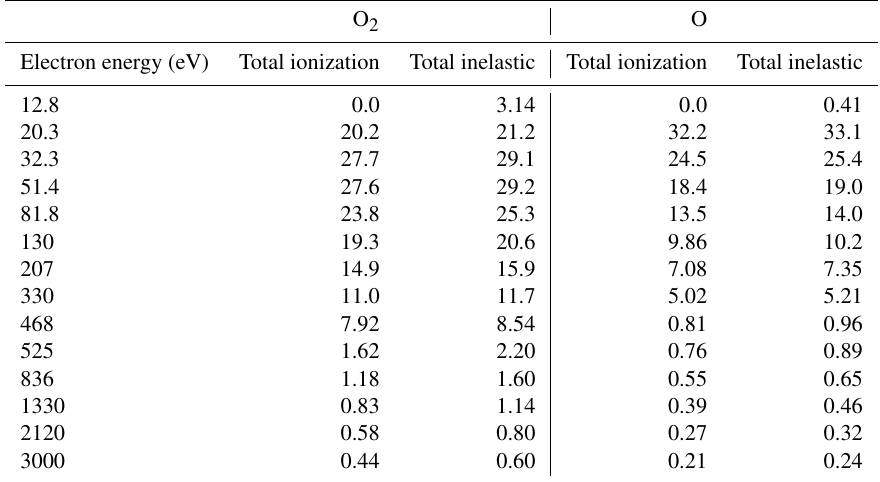
Table 2. Electron impact total ionization and total inelastic cross sections (in units of 10 − 16 cm 2 ) for molecular oxygen and atomic oxygen gas (Jackman et al., 1977). O 2 O